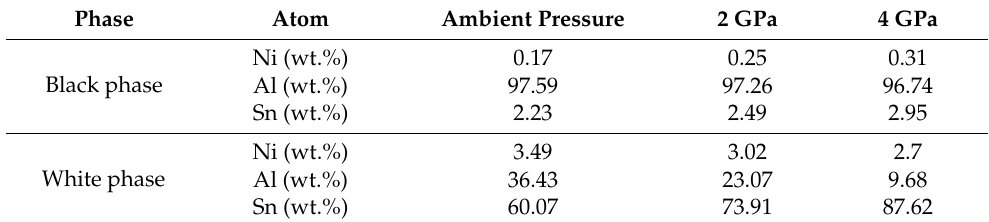
Table 2. The EDS analysis of the phases under different pressures.